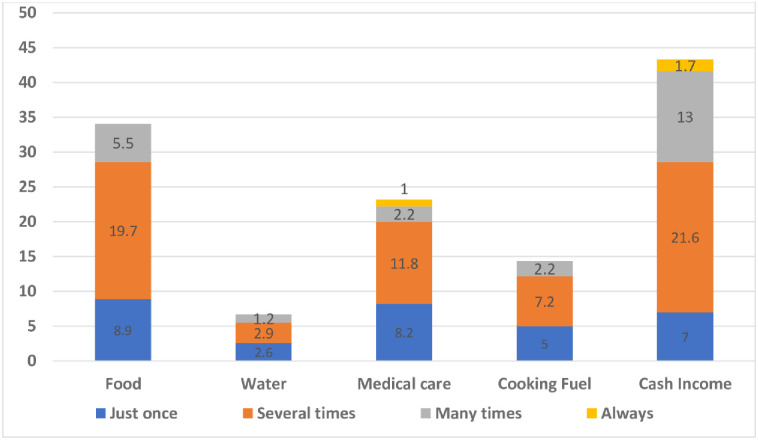
Percentage of participants who went without basic necessities.